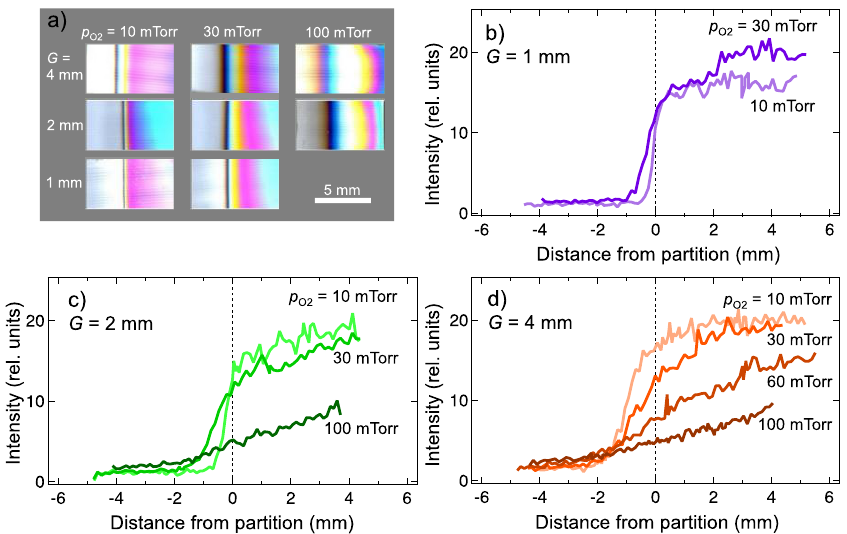
Figure 2. ( a ) Optical-scanner images of CeO 2 / Si samples prepared by partitioned single-target PLD with various gaps and oxygen ambient pressures. In all the images in the figure the right hand-side corresponds to the target side during deposition. The center in the horizontal direction of each image corresponds to the partition position during deposition. ( b )–( d ) EDX signal intensity profile of Ce as functions of position on the CeO 2 / Si samples. The partition–substrate gap is 1 mm ( b ), 2 mm ( c ) and 4 mm ( d ).